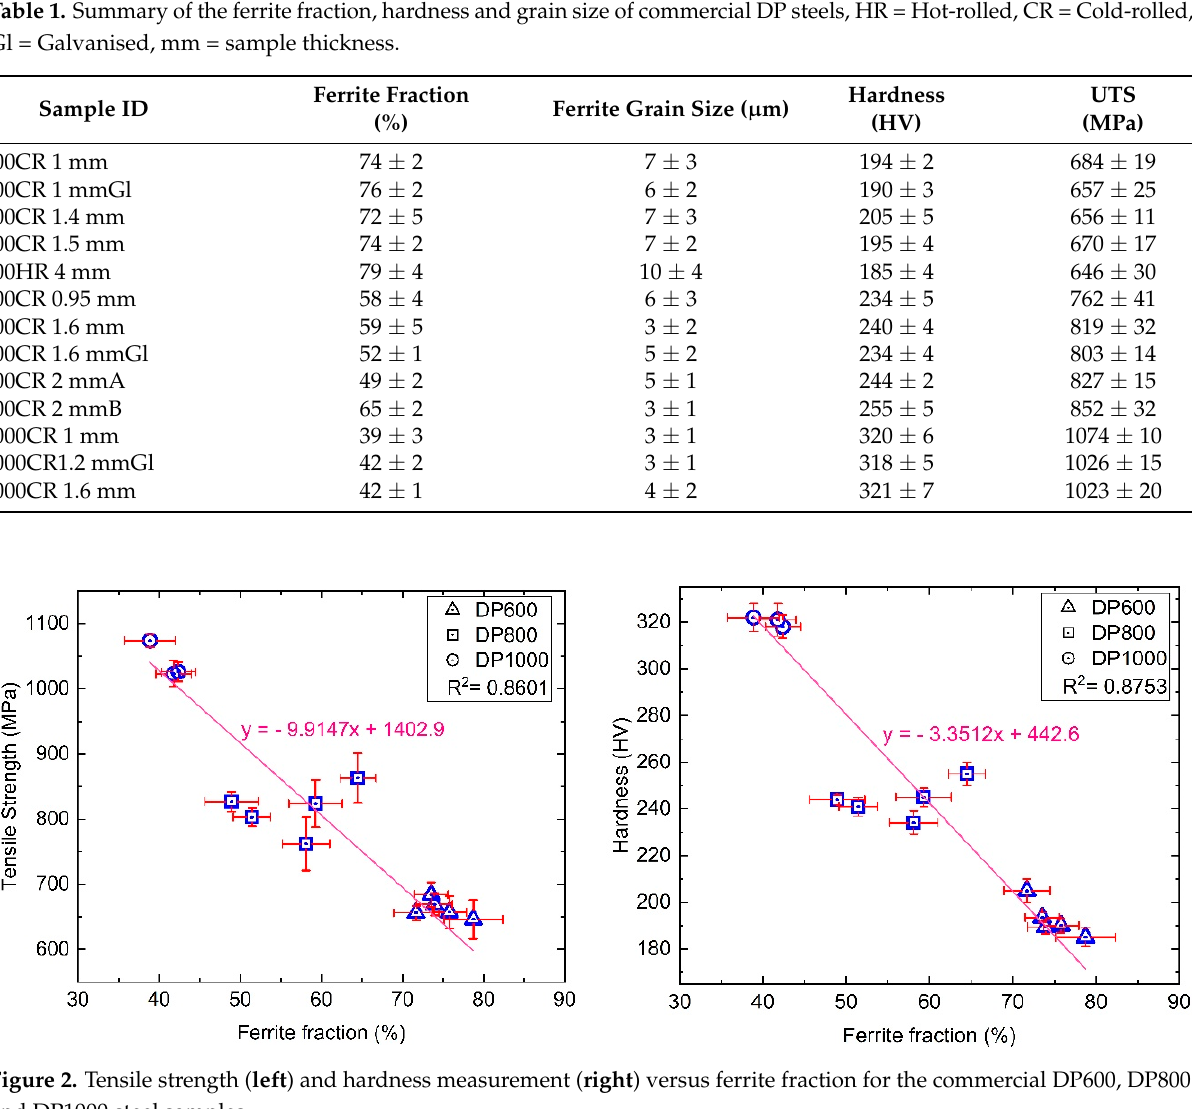
Figure 2. Tensile strength ( left ) and hardness measurement ( right ) versus ferrite fraction for the commercial DP600, DP800 and DP1000 steel samples.